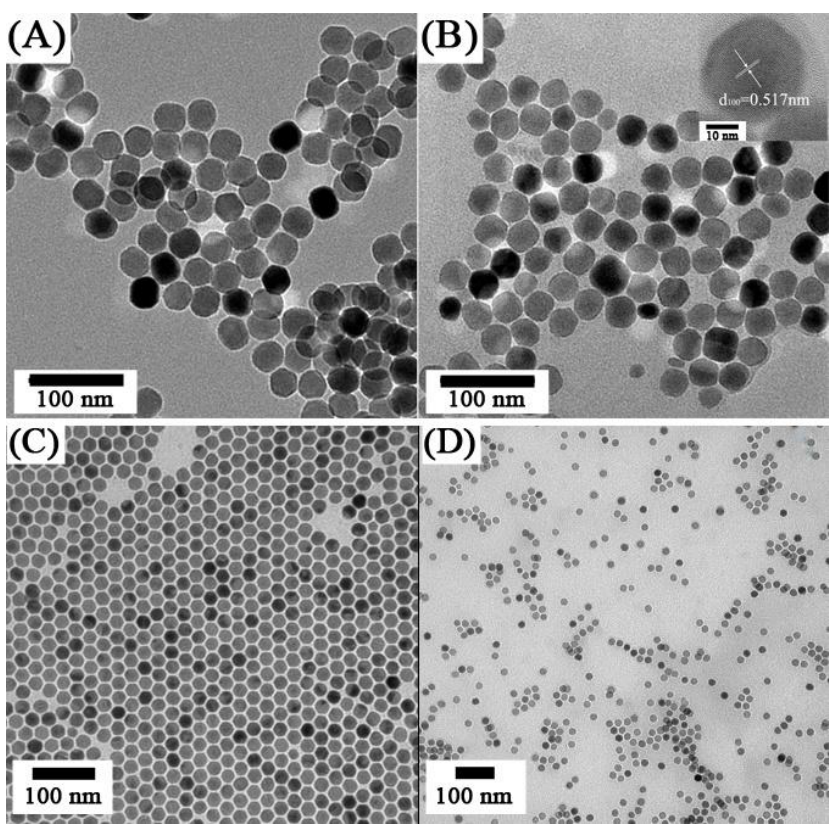
Figure 7. TEM images of oleic acid-UCNPs dispersed in ( A ) cyclohexane and ( B ) citrate coated-UCNPs dispersed in water—Inset: HRTEM image of single nanoparticle ([104], reproduced by permission of Elsevier) and (ii) TEM images of NaYF ( C ) oleate-stabilized, ( D ) ligand-exchanged with PVP ([108], reproduced by permission of the Royal Society of